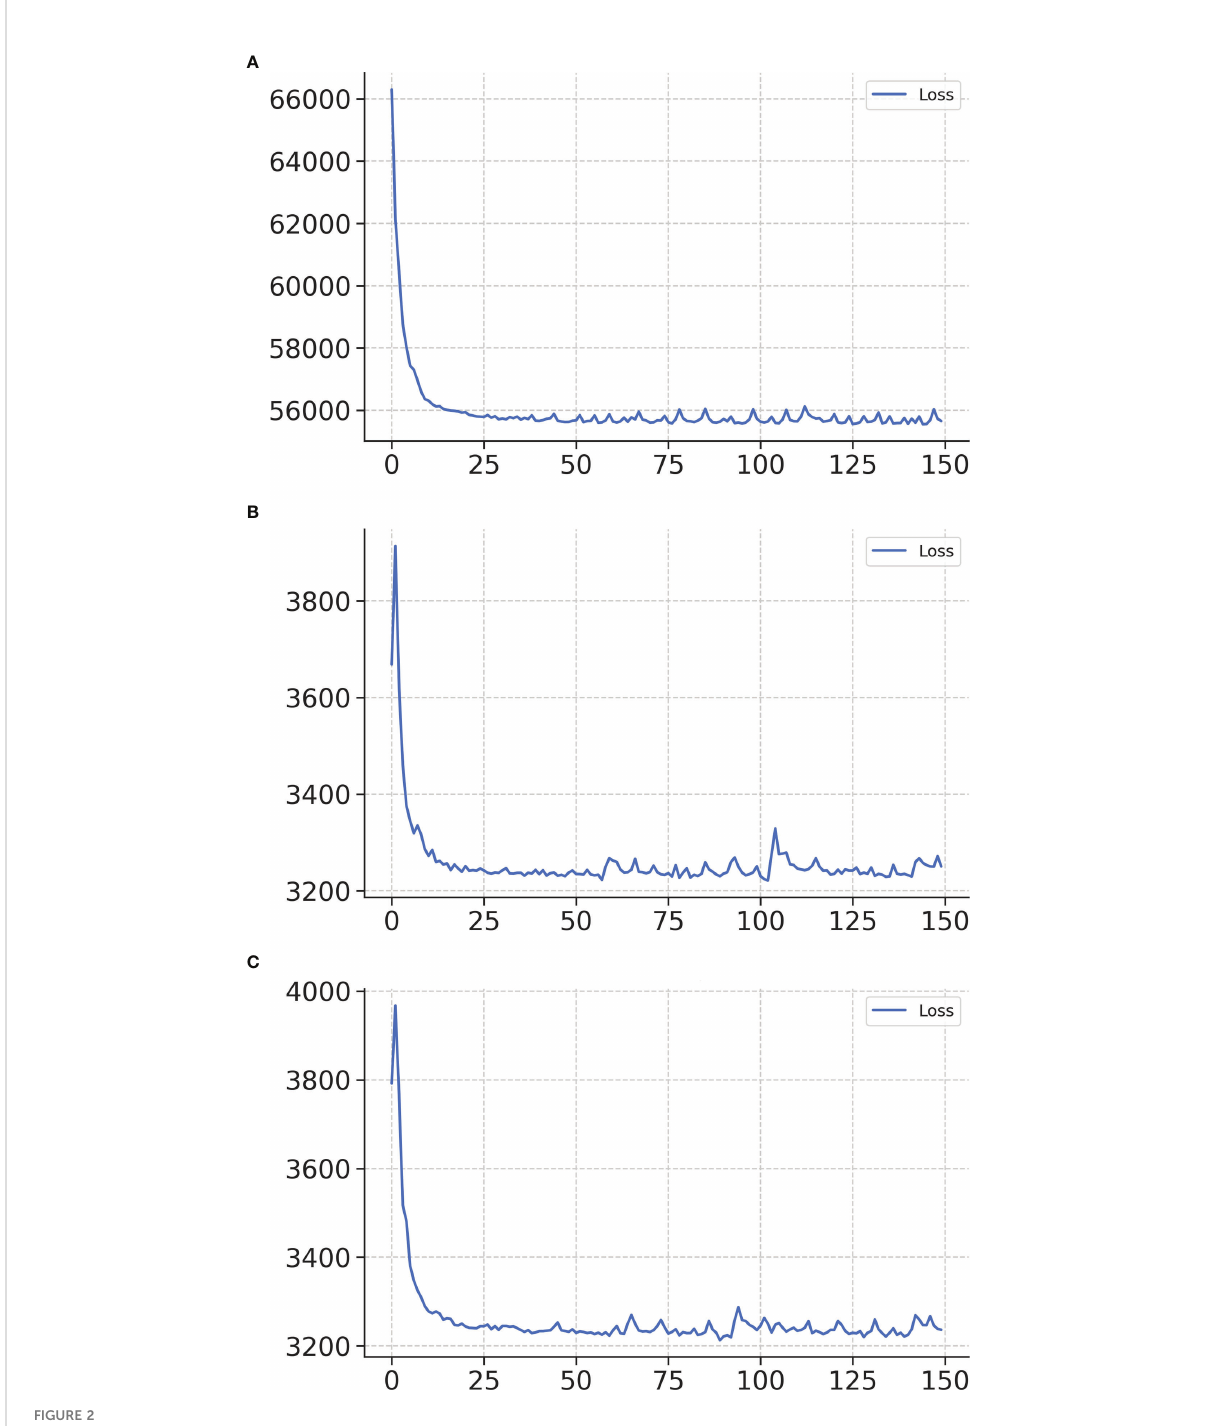
FIGURE 2 Training loss curves of networks in the survival network (A) , treatment recommendation network of surgery alone (B) , and treatment recommendation network of adjuvant therapy (C) . The x-axis represents the number of iterations, and the y-axis represents the loss